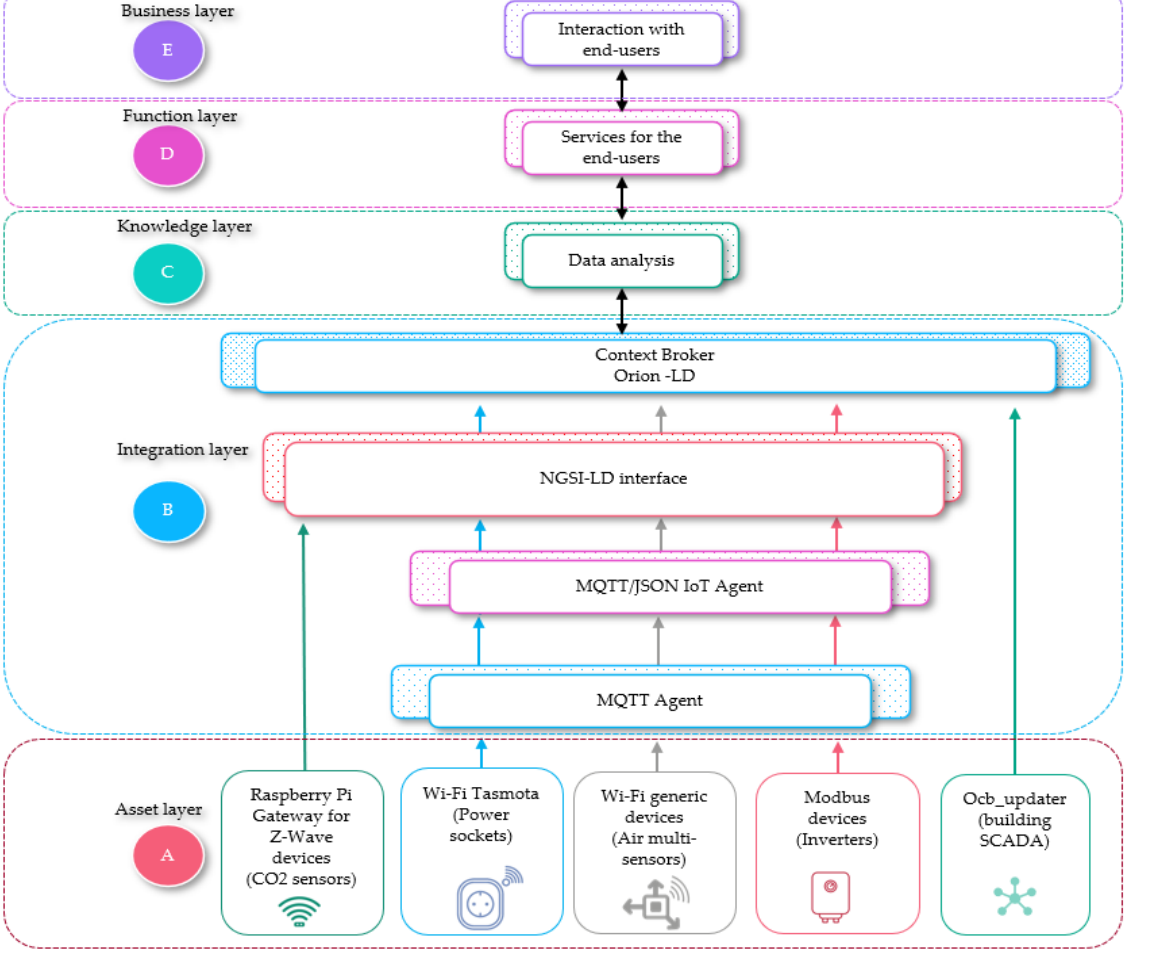
Figure 4. Implementation of PHOENIX architecture in PoC.